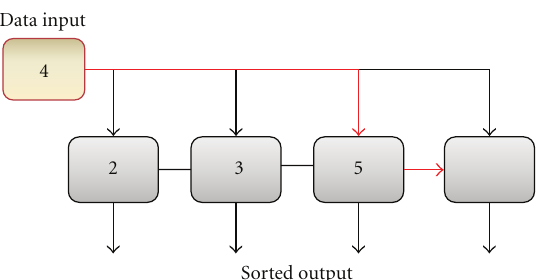
Figure 5: Linear sorter node